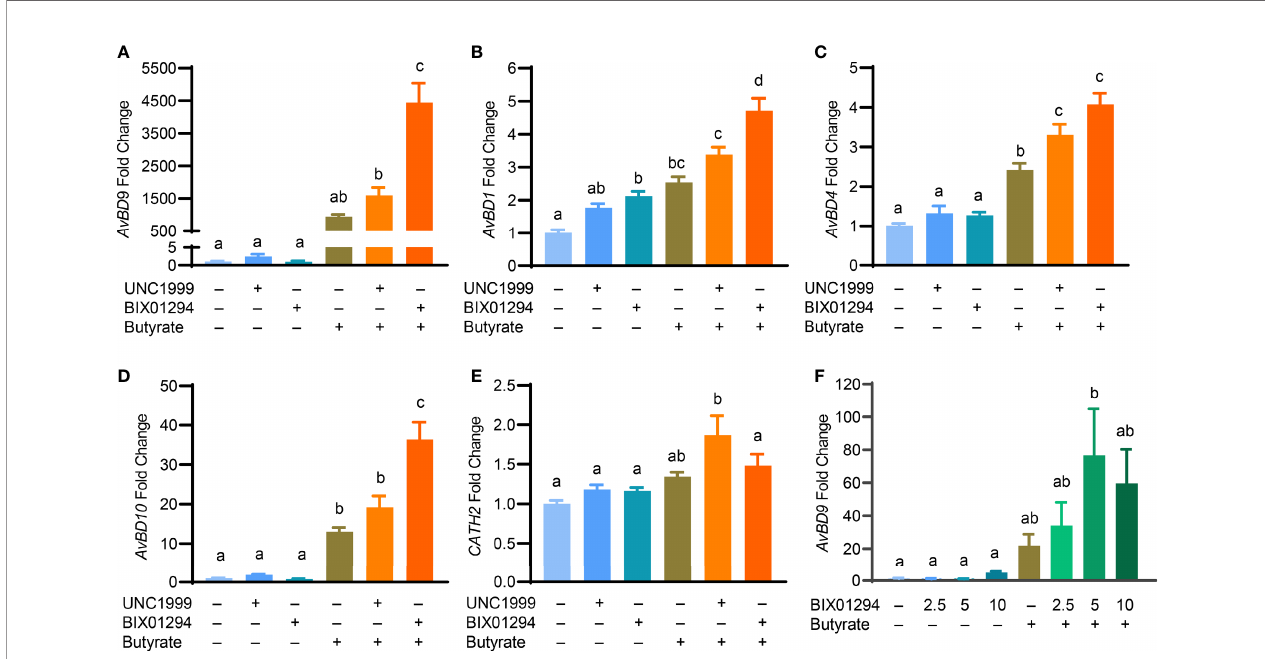
FIGURE 6 | Synergistic induction of the HDP mRNA expression in HD11 cells and peripheral blood mononuclear cells (PBMCs) between butyrate and an HMTi. Chicken HD11 macropahges were stimulated in duplicate with 2 mM butyrate with or without either 5 m M BIX01294 or 5 m M UNC1999 for 24 h, followed by RT- qPCR analysis of the gene expression levels of AvBD9 (A) , AvBD1 (B) , AvBD4 (C) , AvBD10 (D) , and CATH2 (E) . (F) Chicken PBMCs were stimulated in duplicate with indicated concentrations ( m M) of BIX01294 in the presence or absence of 1 mM butyrate for 24 h, followed by RT-qPCR of AvBD9 expression. Results are shown as means ± SEM of 2-3 independent experiments. The treatments not sharing a common superscript are considered signi fi cantly different ( P < 0.05) based on one-way analysis of variance and post hoc Tukey ’ s